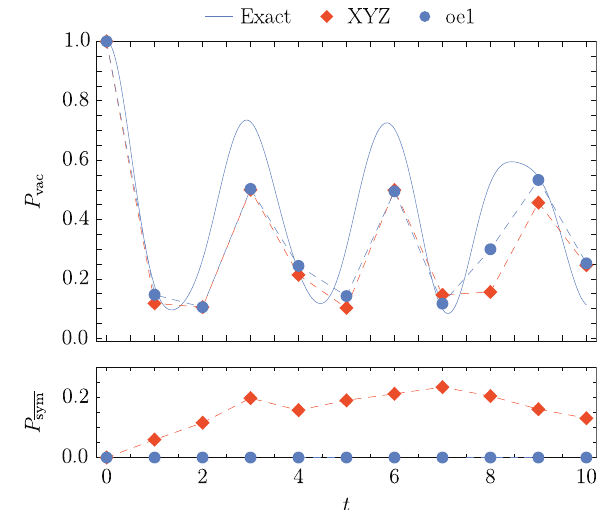
FIG. 1. The numerical simulation of the projection on the bare- vacuum state P vac (upper panel) and the population of symmetry- forbidden states P sym (lower panel) when the system is initialized in the bare-vacuum state for N = 6, μ = 0.1, and x = 0.6. Differ- ent term orderings for the Trotterized evolution are considered: the odd-even ordering defined in Eq. (11) (blue dots) and the XYZ ordering defined in Eq. (14) (red diamonds). The blue line denotes the exact